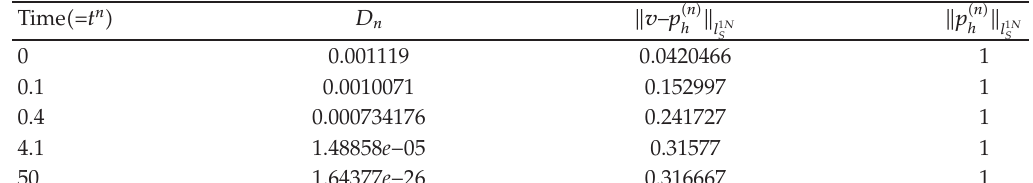
Table 9: Numerical results: Stable fixes point.